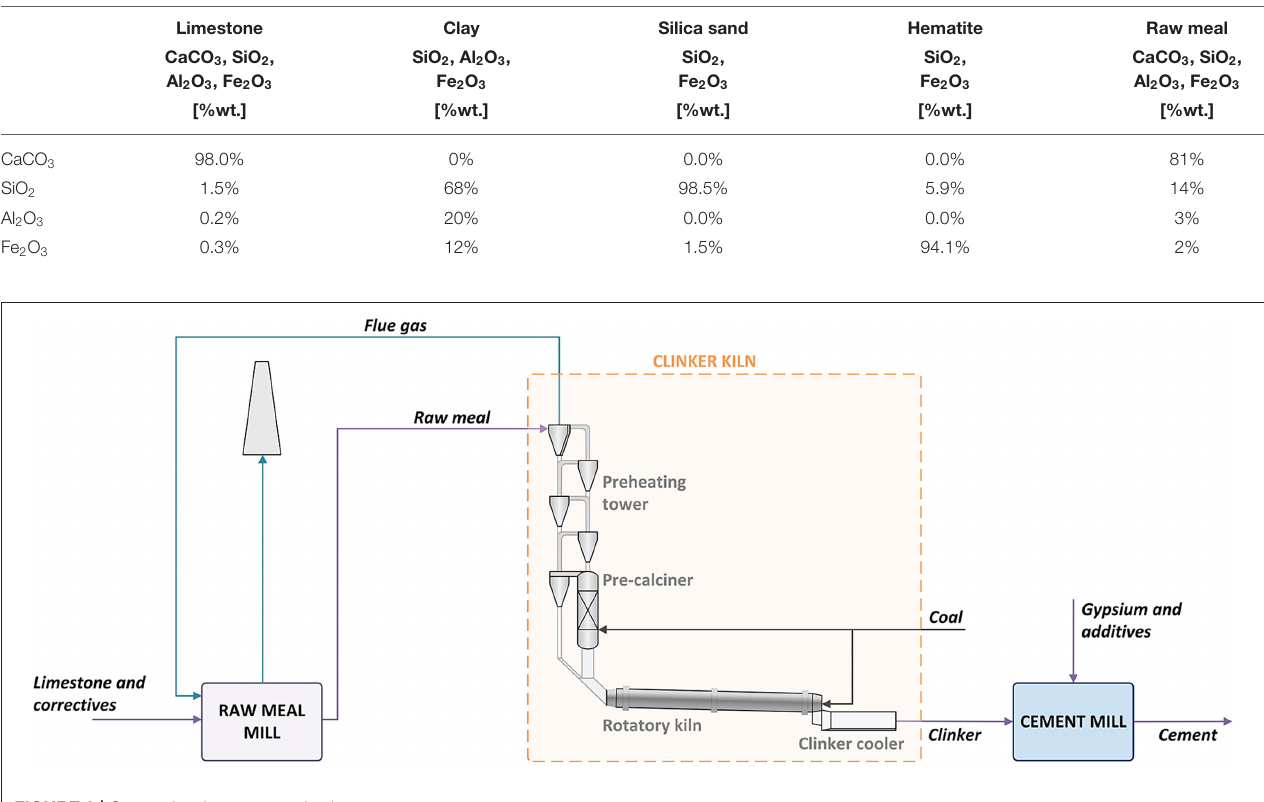
FIGURE 2 | Conventional cement production